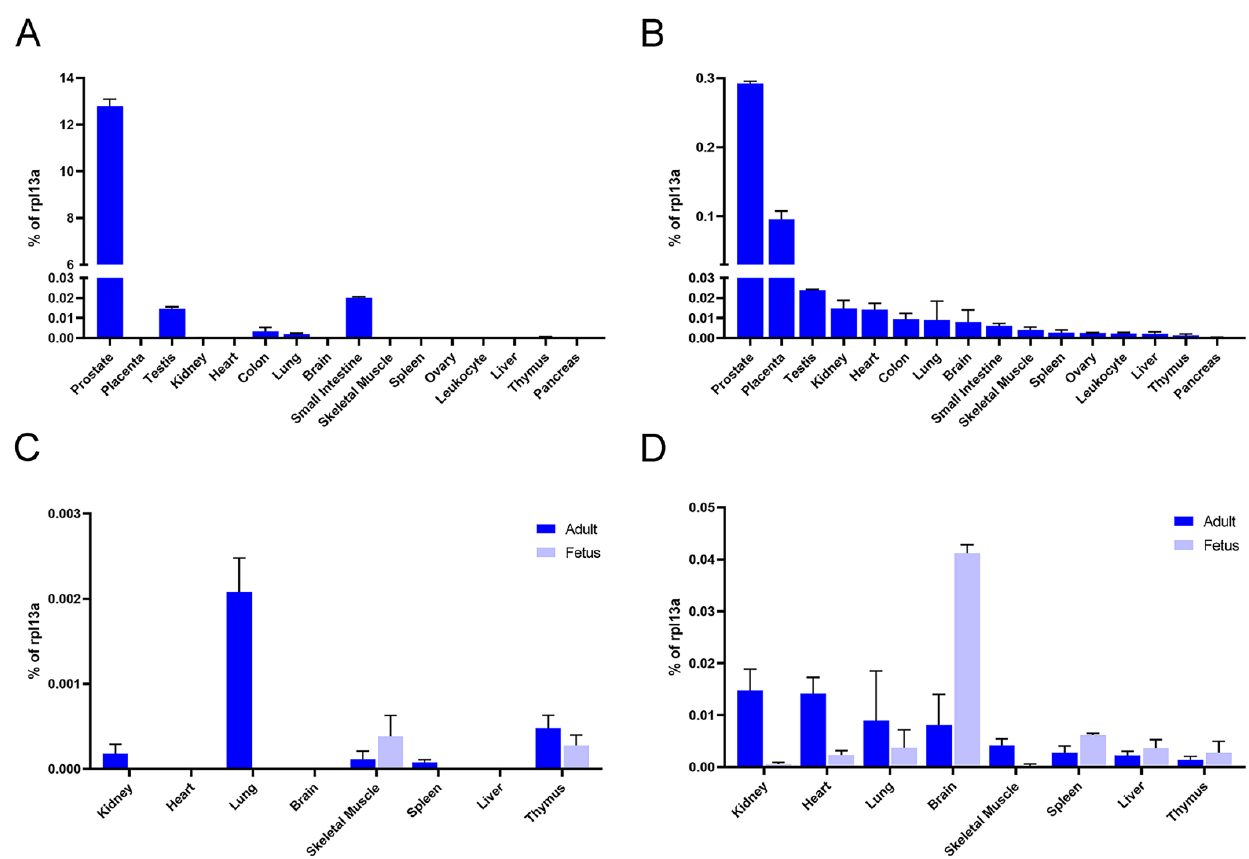
Figure 9. Expression of KLK4 and KLK4T2 in different tissues. qPCR was run on MTC panels using the primer pairs KLK4Ne3f-KLK4Ne4r amplifying KLK4 ( A , C ) and K4T2e23f-K4T2e3r specific for KLK4T2 ( B , D ). The results are given as concentration relative to the transcript concentration of the housekeeping gene rpl13a , which was amplified using rpl13a-f–rpl13a-r. Samples were run as triplicates, and error bars indicate one standard deviation. In ( A , B ), expression is shown in human adult tissue, whereas in ( C , D ) expression in fetal tissue has been included as indicated in figure legends.